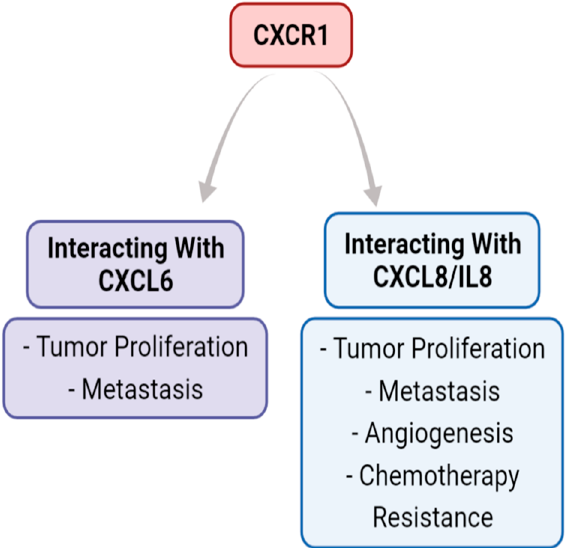
Figure 3. The role of the CXCR1 axis in the tumor microenvironment. The CXCR1 axis binds CXCL6 and CXCL8, but not the other five ligands that CXCR2 binds. The literature supports that CXCL6 and CXCL8 binding with CXCR1 both have pro-tumorigenic outcomes that can increase metastasis.